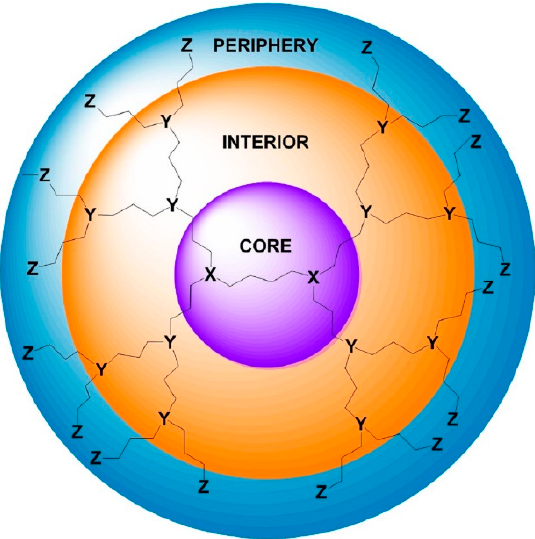
Figure 1. Schematic representation of the three structural parts of a dendritic polymer.